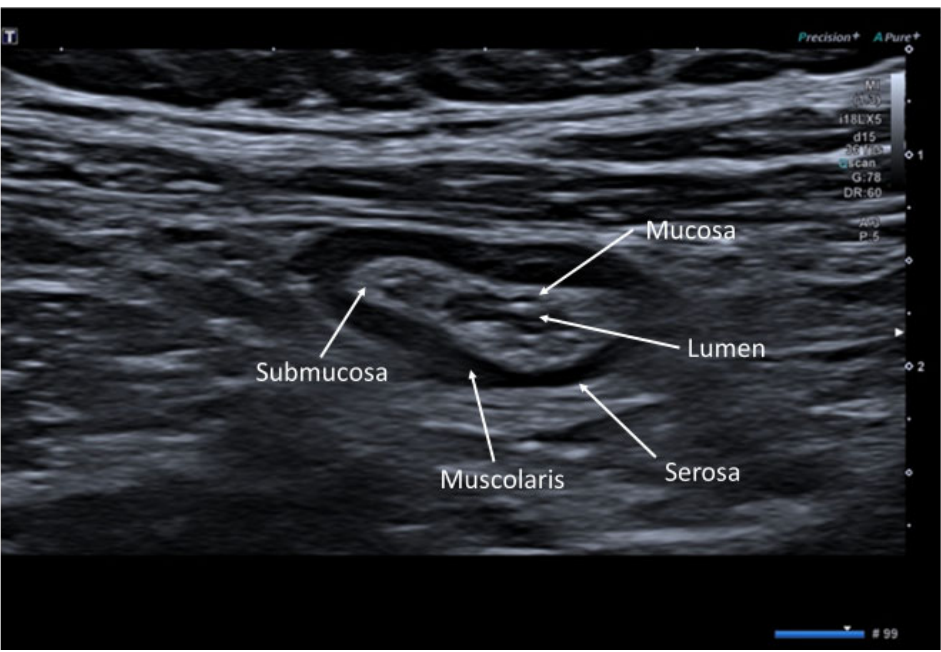
Figure 2. Transverse scan image of a normal bowel loop, in which the succession of hyperechoic and hypoechoic layers is evident.